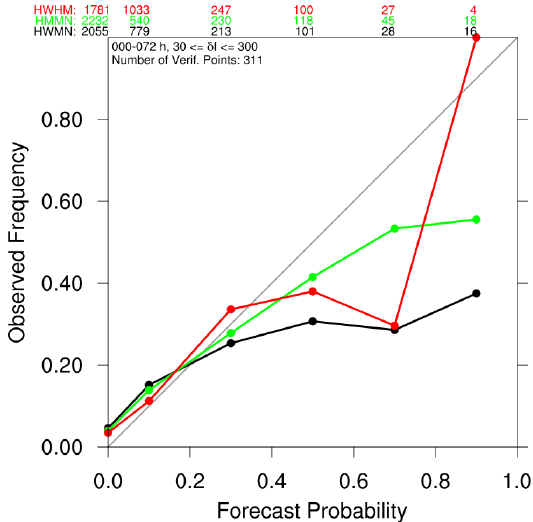
Figure 7. HWRF (black), HMON ensemble (green), and combined HWRF and HMON ensemble (red) reliability diagrams for the probability of 24-h TC maximum wind speed change >= 30 knots during each 24 h period from 0 to 24 h to 48–72 h during 2017–2019. The number of cases within each category is given along the top of each